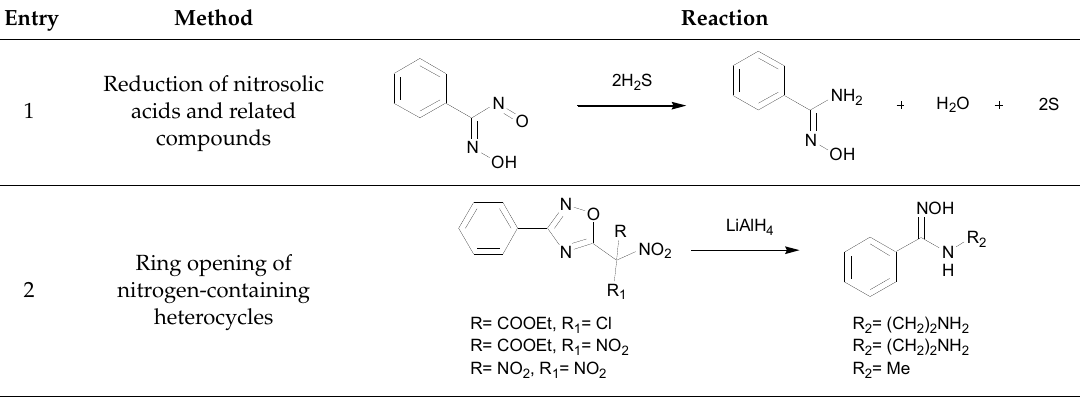
Table 4. Miscellaneous reactions allowing the preparation of amidoximes.